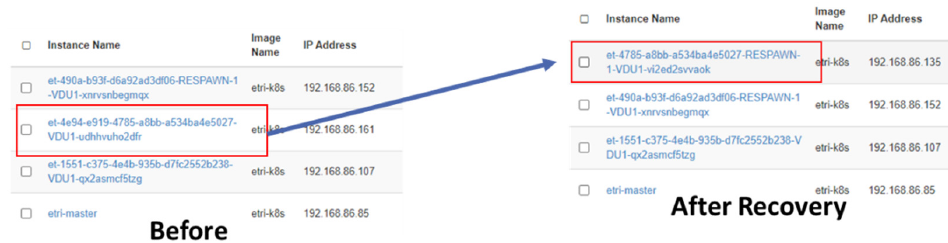
Figure 17. Recovery Result.